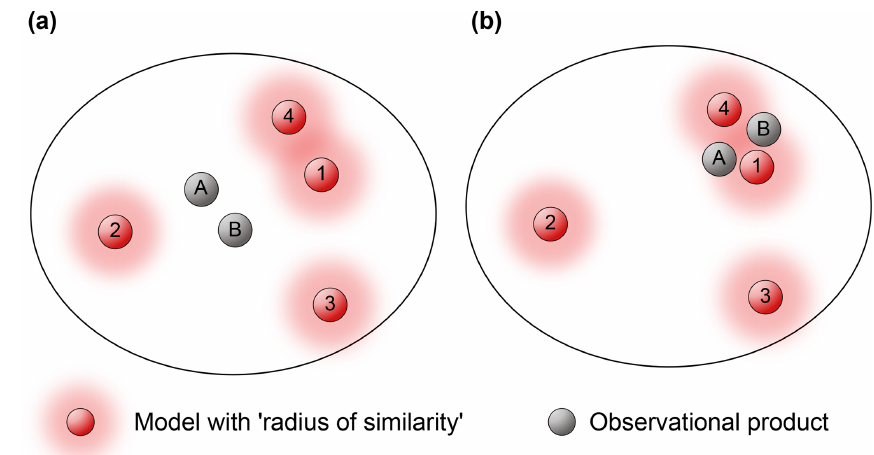
Figure 1. A two-dimensional projection of an inter-model distance space, showing different models and observational estimates, with a radius around models that could be used to determine model dependence. The radius around observations might be related to the uncertainty associated with a given observational estimate. Panels (a) and (b) illustrate how the relative position of observational data sets in this space could complicate this definition of model